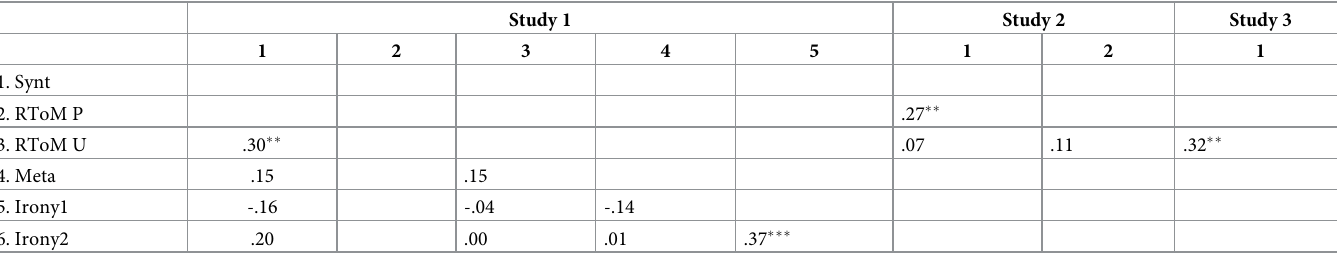
Table 9. Partial correlation of predictors in Study 1–3 controlled for children’s age in